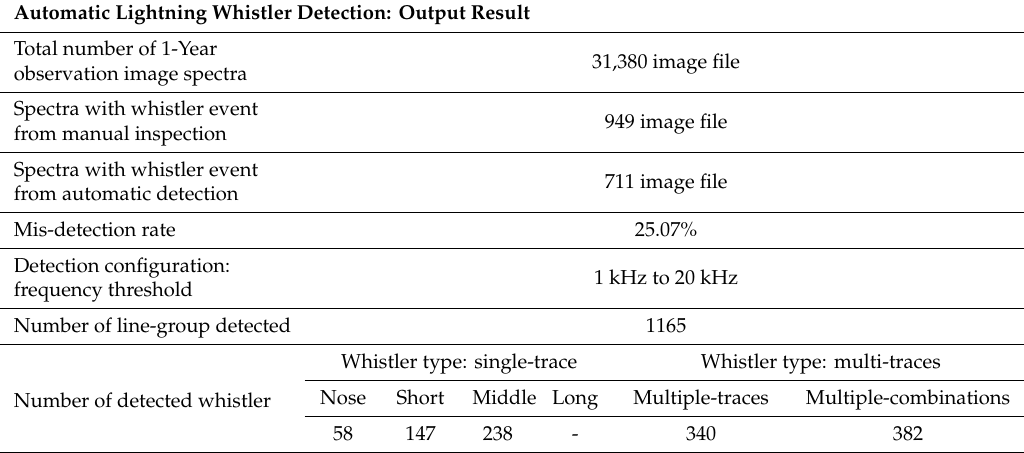
Table 3. The comparison detection result using the defined algorithm and manual